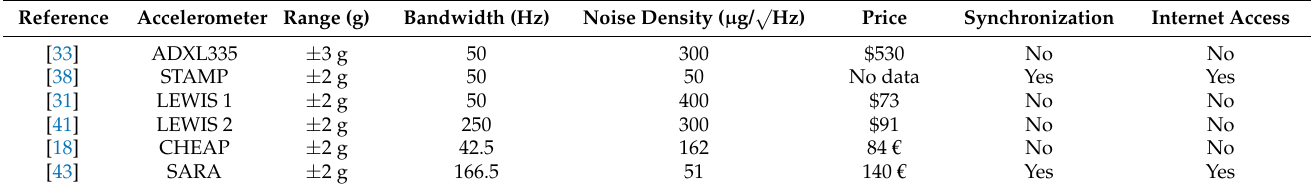
Table 1. Comparison of the main characteristics of low-cost monitoring systems based on Ar- duino